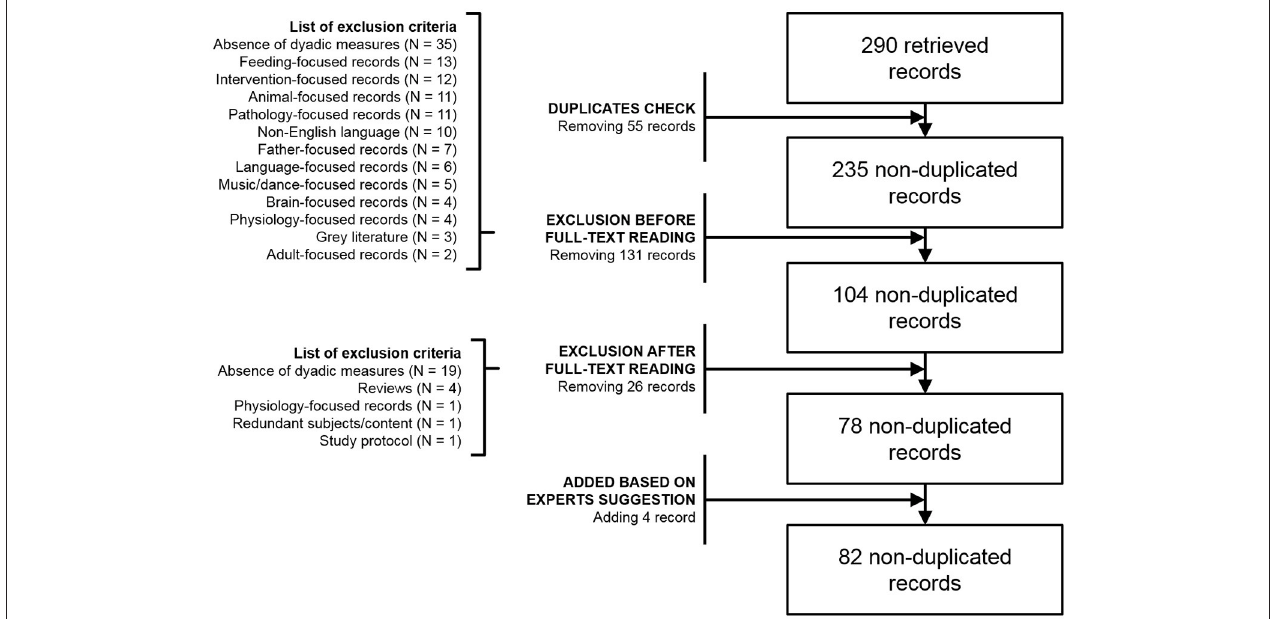
FIGURE 1 | Flow chart of literature search and study